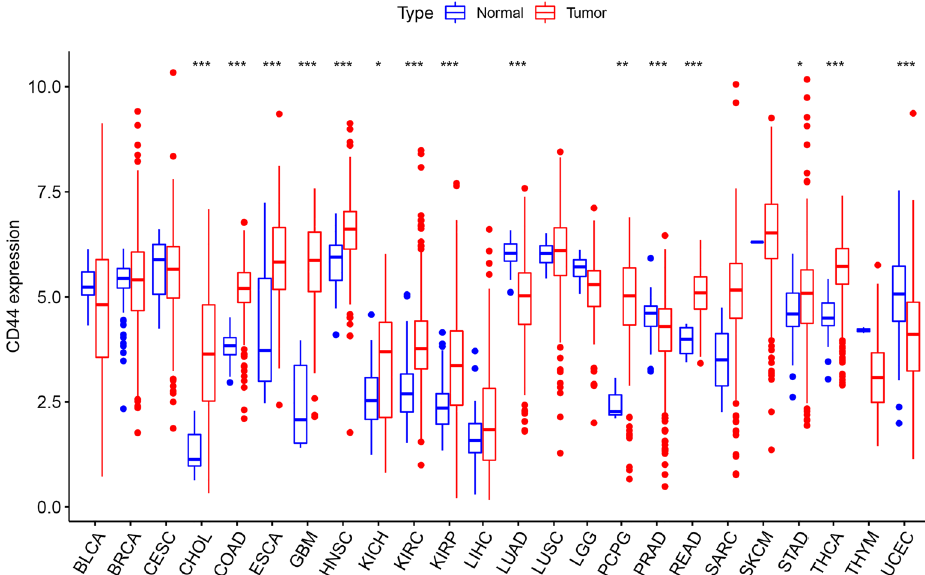
Figure 1. The expression level of CD44 in different cancers based on the TCGA database. CD44 cluster of differentiation-44, TCGA The Cancer Genome Atlas. * P < 0.05, ** P < 0.01, and *** P < 0.005.